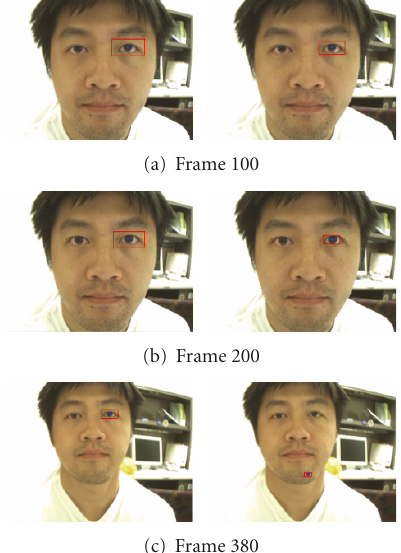
Figure 12: Comparison of using AR versus using Gaussian tran- sition model in the scale model. In each subfigure, the left image shows the result from AR scale transition model, and the right one shows the result from the Gaussian scale transition model.